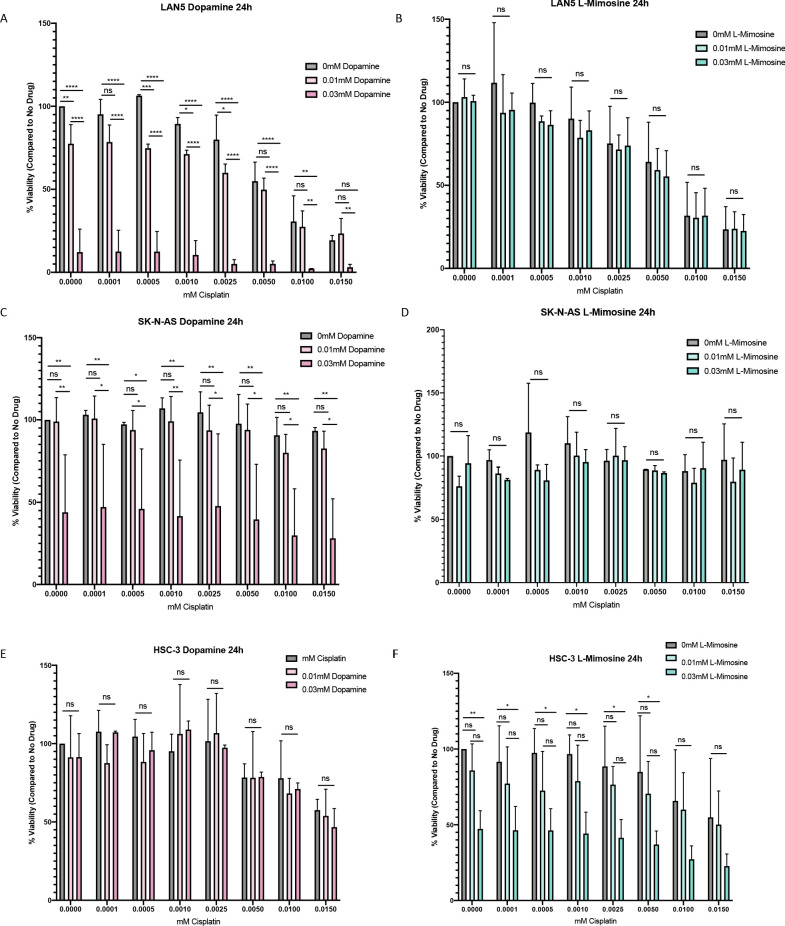
Dopamine and L-mimosine do not protect cancer cell lines from cisplatin-induced death 24 hr following cisplatin treatment.Neuroblastoma (NBL) and oral squamous cell carcinoma cell lines were pretreated for 12 hr vehicle control, or either dopamine or L-mimosine at either 0.01 mM or 0.03 mM. Cells were then treated with increasing concentrations of cisplatin and incubated for 24 hr (48 hr data shown in Figure 6a-f). An alamarBlue assay was used to determine cell viability. Results are displayed as % compared to untreated control. (A and D) LAN5, (B and E) SK-N-AS, (C and F) HSC-3. *=p<0.05, **=p<0.01, ***=p<0.005, and ****=p<0.001, as per two-way ANOVA with a Tukey post-test. N=3.